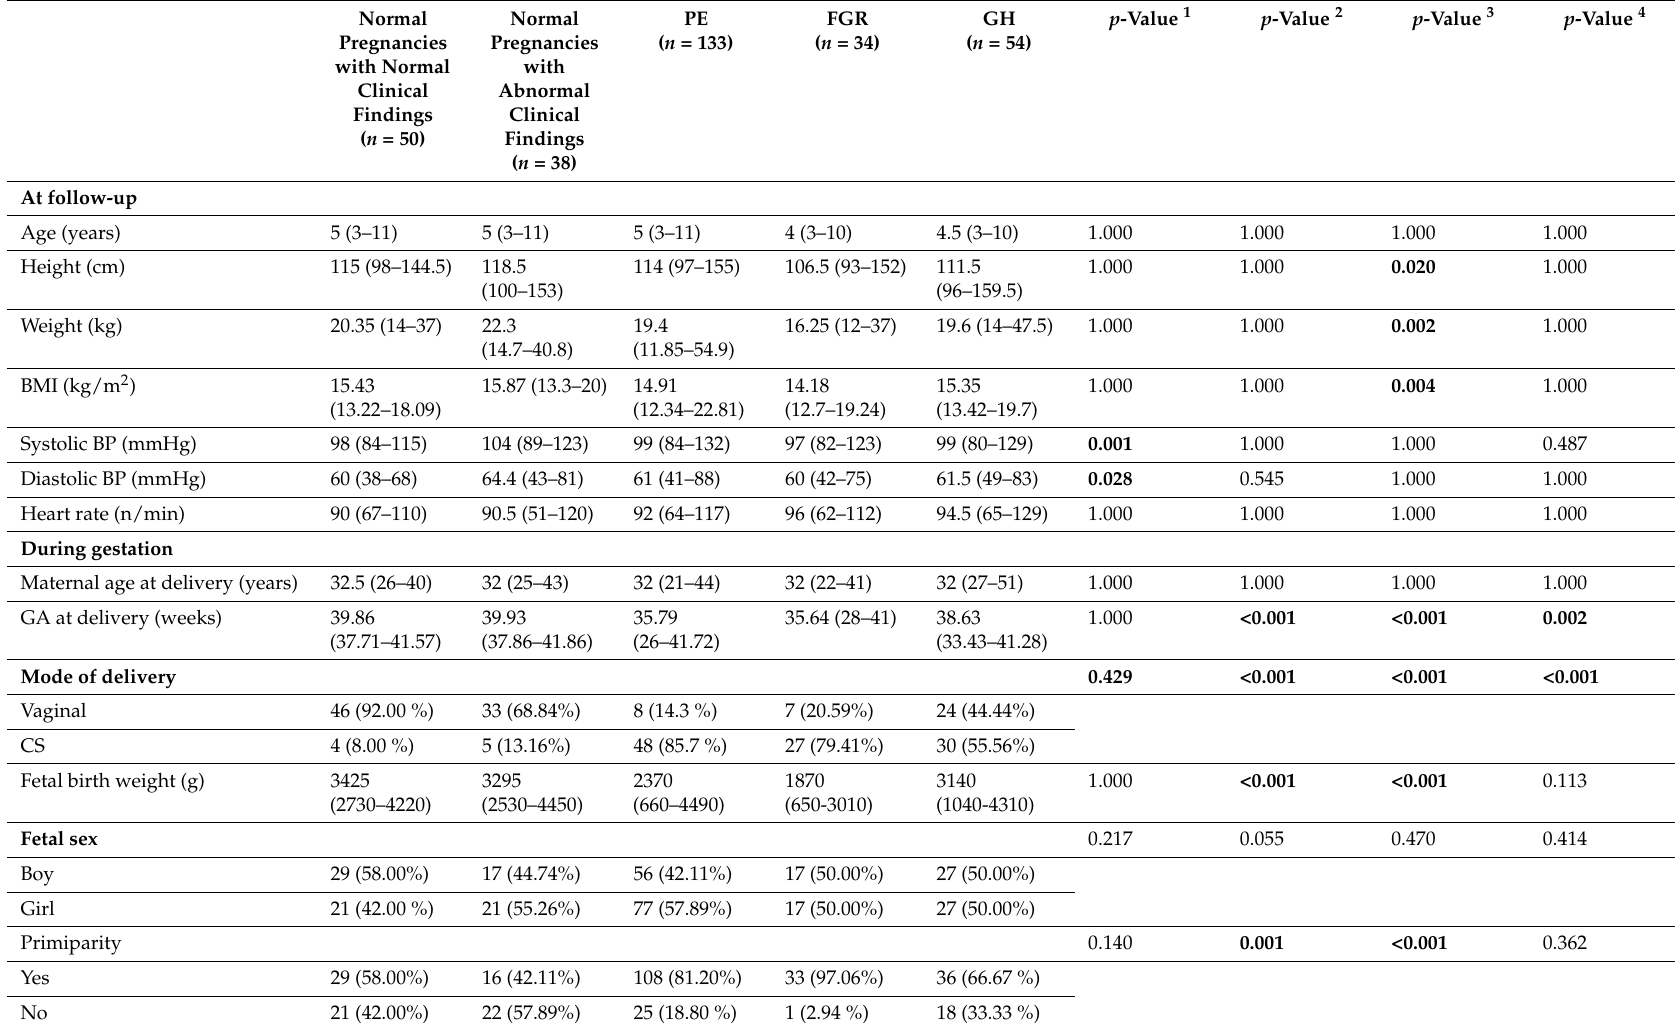
Table 3. Characteristics of cases and